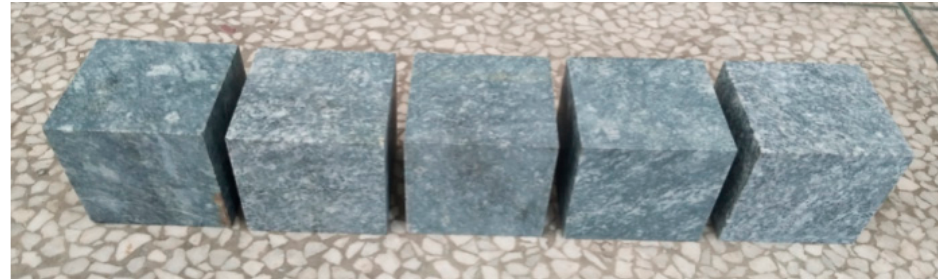
Figure 2. Granite specimens with the size of 70 mm × 70 mm × 70 mm.